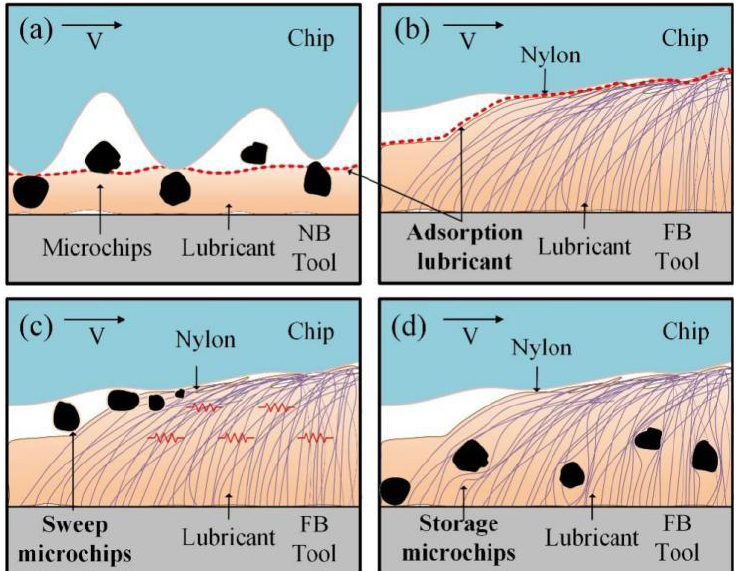
Figure 13. ( a ) Formation mechanism of chip morphology by the NB; ( b ) Adsorption capacity of the flocked broach for lubricant; ( c ) Effect of elastic recovery of fluff on sweeping microchip; ( d ) The function of the flocked broach to store microchips.